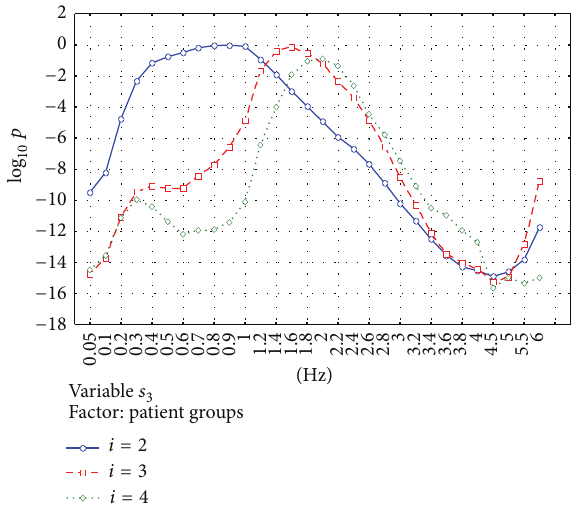
Figure 6: Analysis of the parameter 𝑠 3 . The figure shows the value 𝑝 of the statistical significance of the main effect in MANOVA analysis for the factor “patient groups.” Logarithmic scale is used. Building